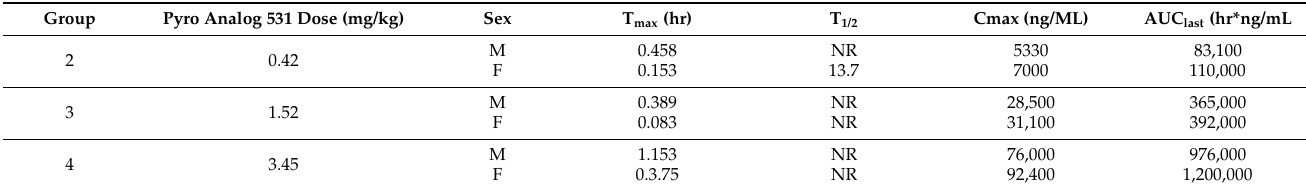
Table 4. Mean toxicokinetic parameters of PS 1 in